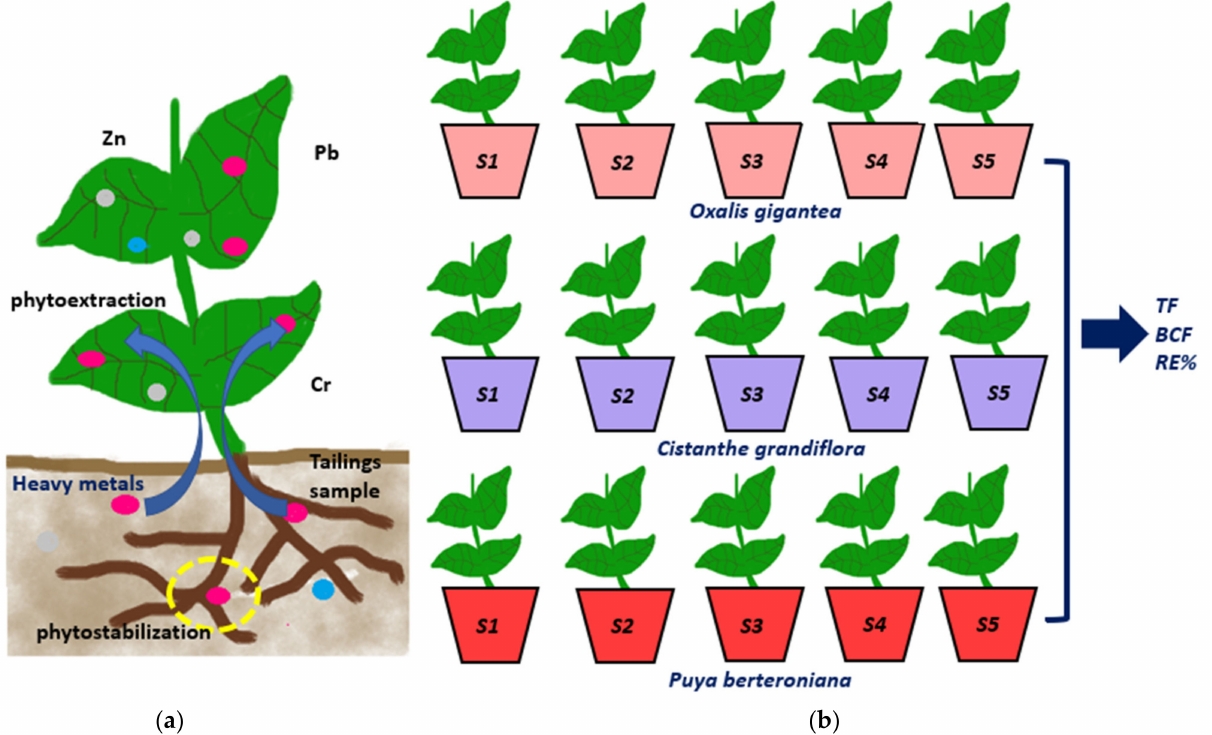
Figure 1. ( a ) Schematic representation of phytoextraction and phytostabilization; ( b ) experimental setup for phytoremediation pot experiments: five triplicates for each species. From these experiments, the translocation factor, bioconcentration factor, and removal efficiency were